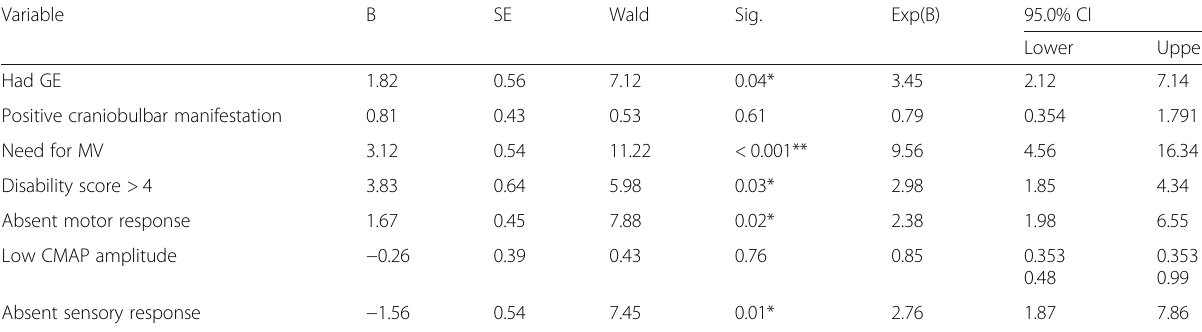
Table 6 Multivariate regression analysis for significant findings in GBS patients with serum CRP > 6 mg/dl